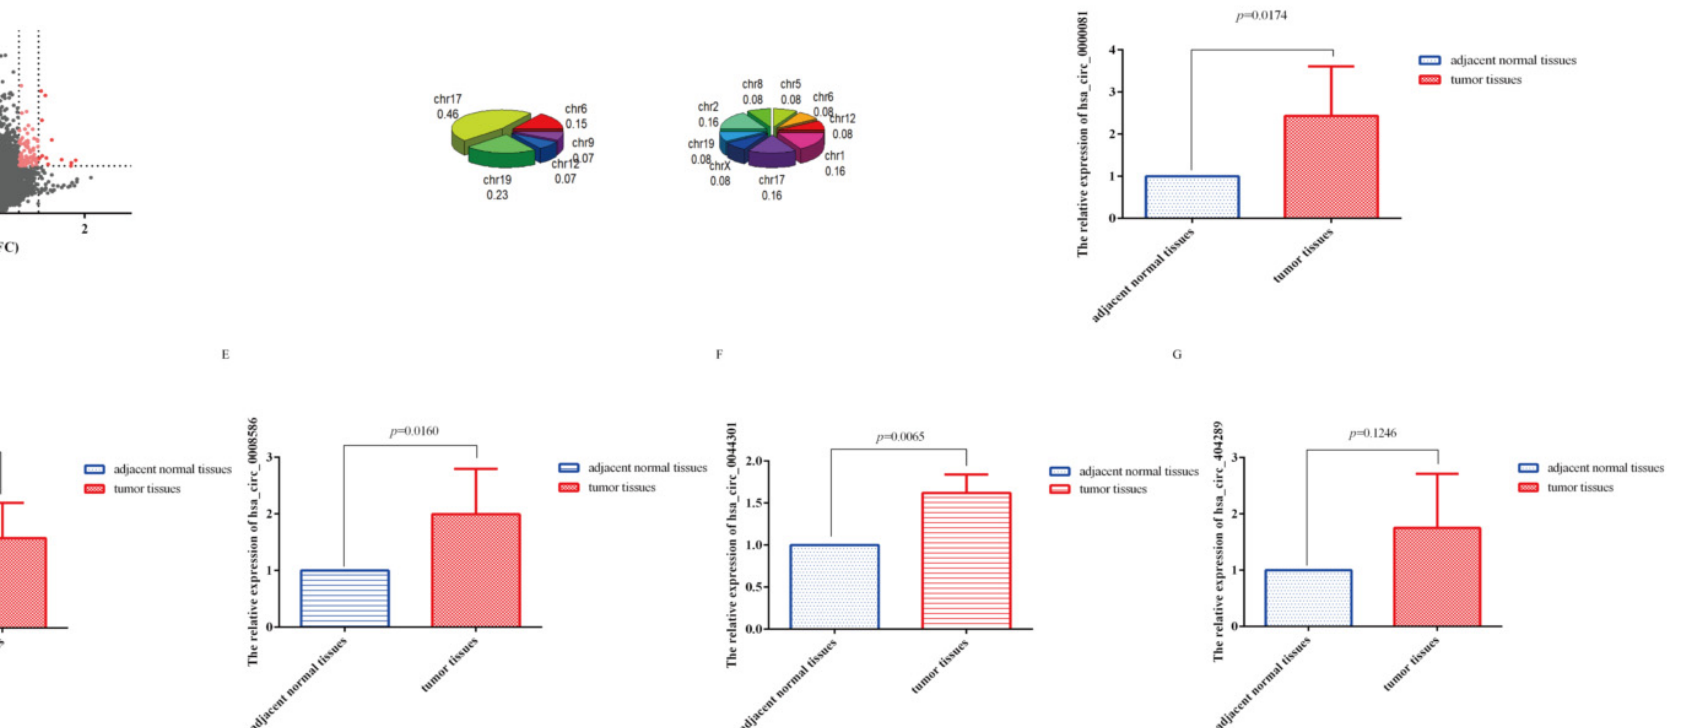
Figure 1. The results of our circRNA microarray. ( A ) Volcano plot of differentially expressed circRNAs showed that the expression of 5775 and 5739 circRNAs was upregulated and downregulated, respectively; pale black indicates no differential expression; dark red indicates significantly upregulated expression, and dark green indicates downregulated expression with absolute FC (fold change) greater than 2 and p value less than 0.05; pale red shows upregulated expression, and pale green shows downregulated expression with absolute FC greater than 1.5 and p value less than 0.05. ( B ) Dysregulated circRNAs located on different chromosomes; the left 3D pie plot shows the location of significantly upregulated expression of 13 circRNAs, and the right plot shows the location of significantly downregulated expression of 12 circRNAs. ( C – G ) QRT-PCR of the relative expression of hsa_circRNA_0000081, hsa_circRNA_0004662, hsa_circRNA_0008586, hsa_circRNA_0044301, and hsa_circRNA_404289 in 61 pairs of gastric cancer tissues, respectively (paired sample t test was performed using the 2 −ΔΔ CT value of each pair of samples).